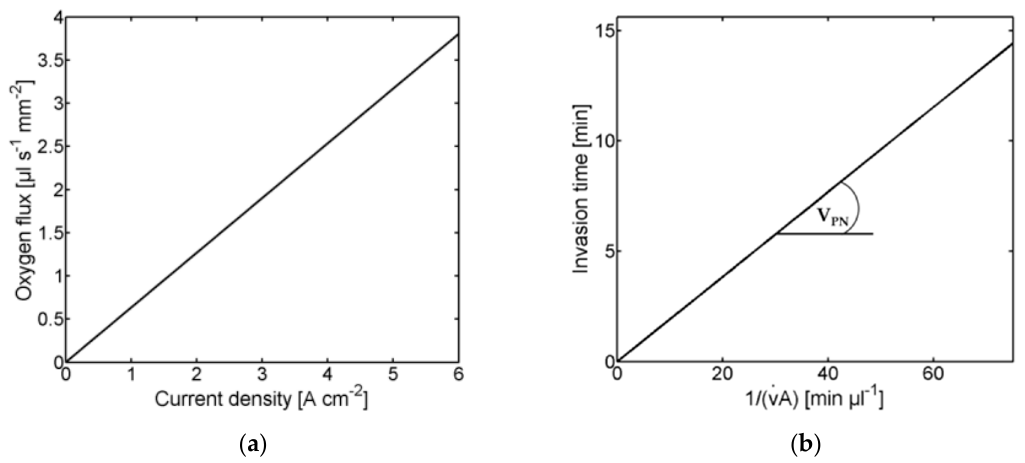
Figure 16. ( a ) Linear dependence of the oxygen volume flux on current density. ( b ) Required invasion time for the constant PN volume V PN (slope) in dependence of the reversed volumetric production flow rate.